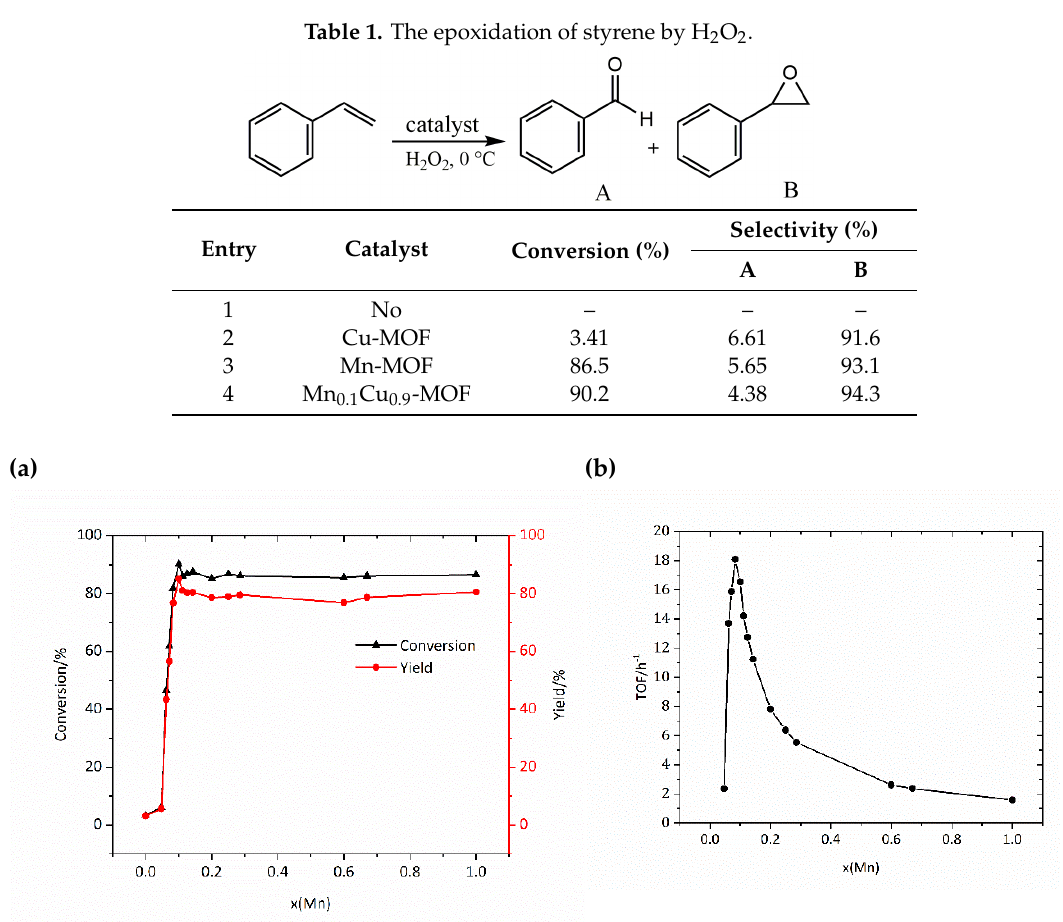
Figure 5. ( a ) Plots of conversion of styrene and the yield of styrene oxide versus a series of Mn x Cu 1 − x - metal–organic framework materials (MOFs), 6 h. ( b ) The turnover frequency (TOF) per Mn site with different mole ratio of Mn, 6 h. Table 1. The epoxidation of styrene by H 2 O 2.